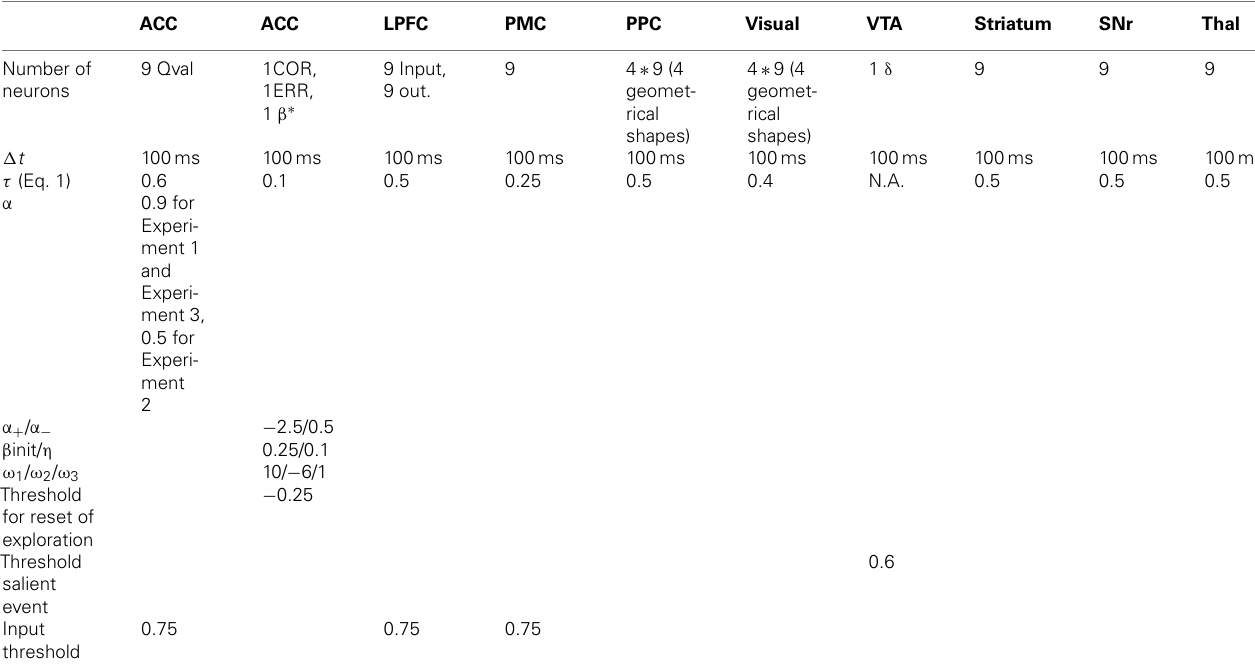
Parameter table showing the number of neurons and the parame- ter values of each module. Most modules contain nine neurons (i.e., a 3 ∗ 3 array topographically encoding different locations in the visual space). The ventral tegmental area (VTA) module con- tains a single simulated dopaminergic neuron dedicated to reward prediction errors computation (Eq. 2). (cid:10) t is the time separating each iteration of the model. t is the time constant of leaky inte- grator neurons used in Eq. 1. The anterior cingulate cortex (ACC) also contains neurons categorizing feedback (COR: correct; ERR: error) used to estimate the current performance of the agent by means of β ∗ and to regulate the exploration rate β through Meta- Learning. Parameters are separately shown for the part of ACC responsible for Reinforcement learning (RL) and the part of ACC responsible for Meta-learning (ML). Since there is no learning in other parts of the model, RL and ML parameters concern only the ACC. α is the learning rate used for RL processes in Eq. 3. α + and α − are the specific learning rates used for the update